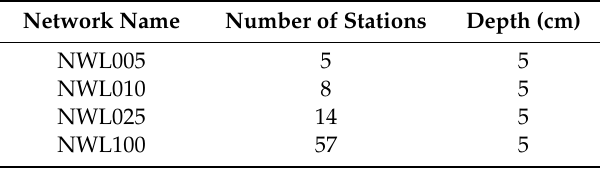
Table 1. Number of stations in the four validation